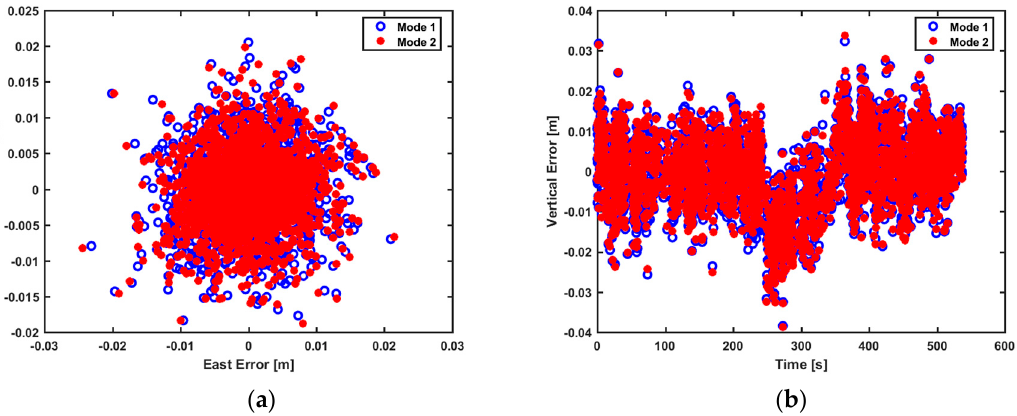
Figure 17. Error scatterplots of modes 1 and 2 in test 1. ( a ) Horizontal direction; ( b ) vertical direction.